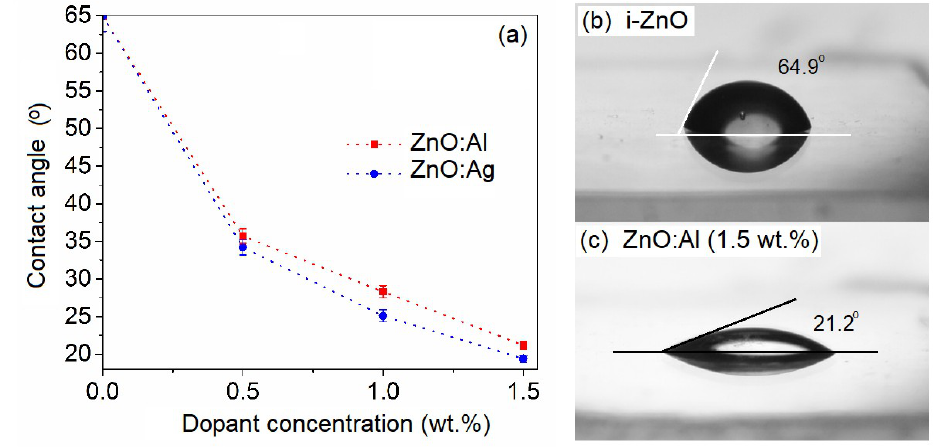
Figure 4. ( a ) Change in contact angle with the increase in the dopant concentration of Al and Ag respectively, ( b ) shape of water droplets on i -ZnO and ( c ) 1.5 wt.% Al-doped ZnO thin films.